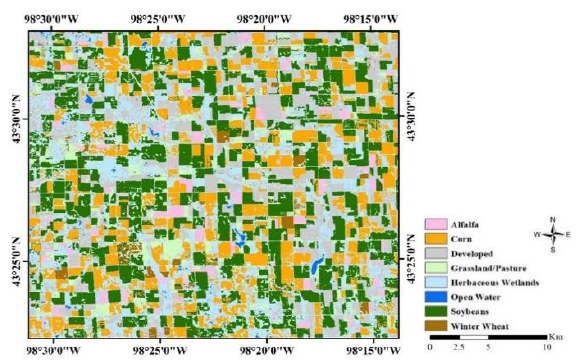
Figure 6. The cropland